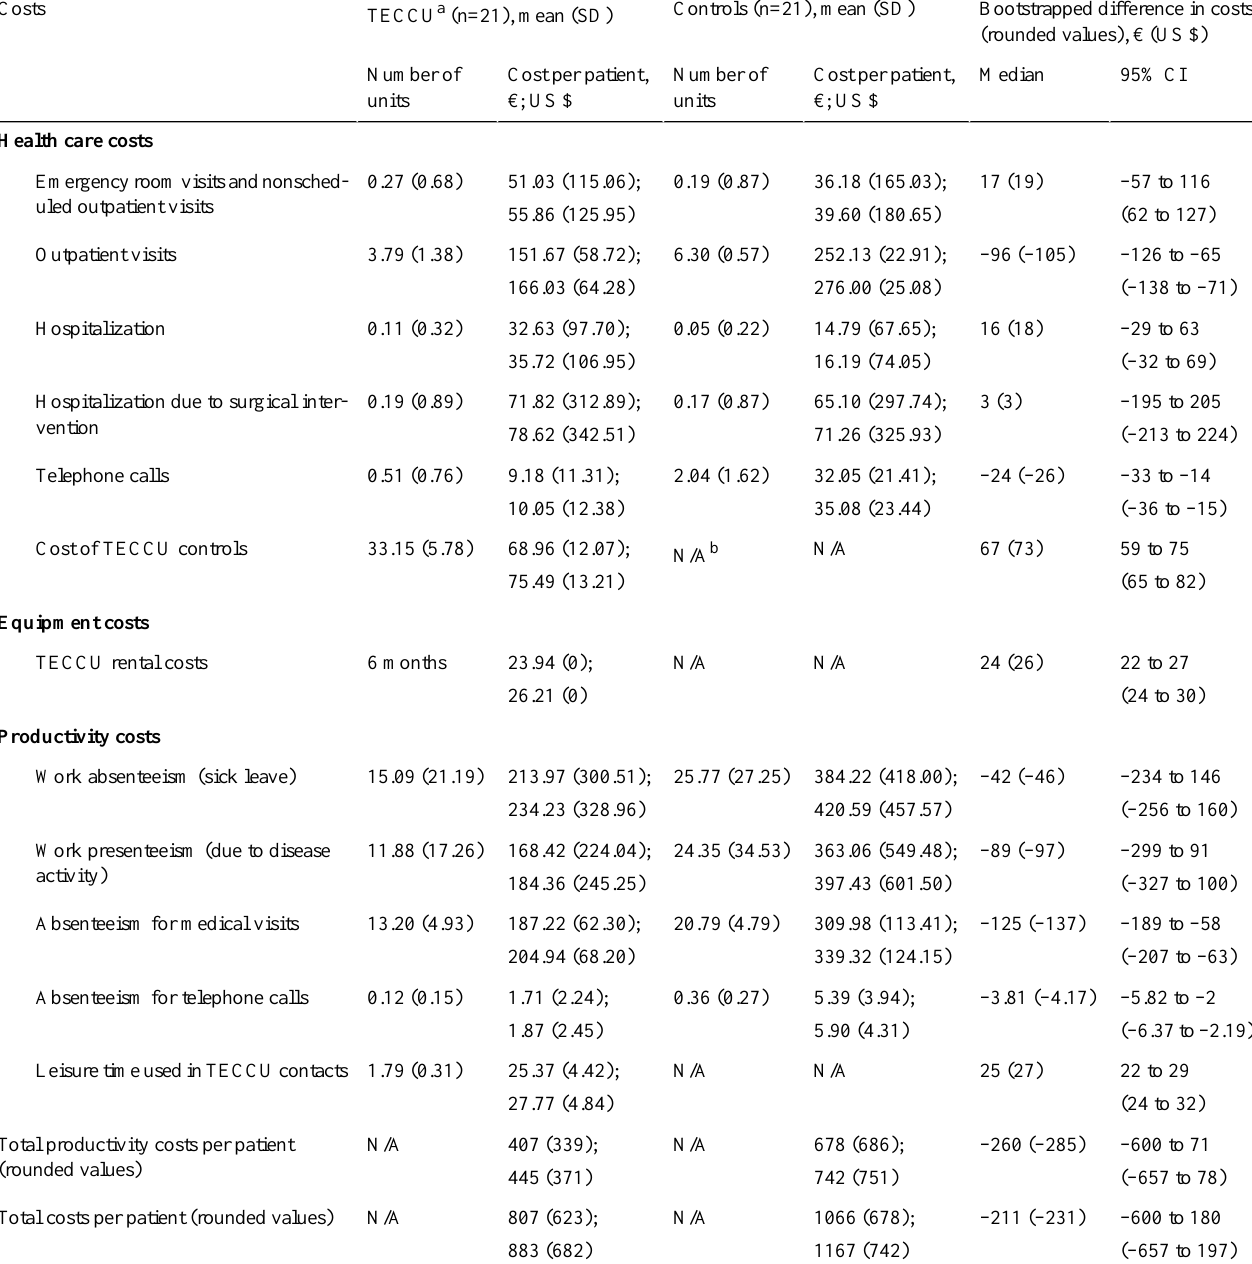
Bootstrapped difference in